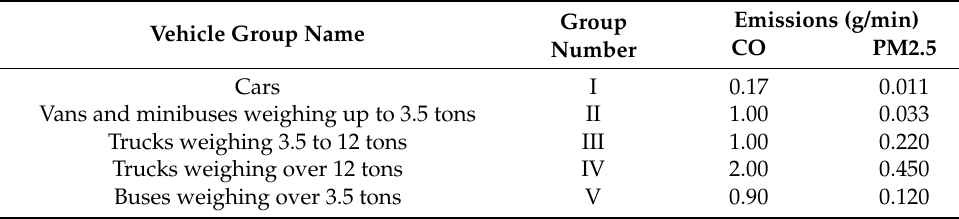
Table 2. Specific emissions of the i -th vehicle-related pollutant